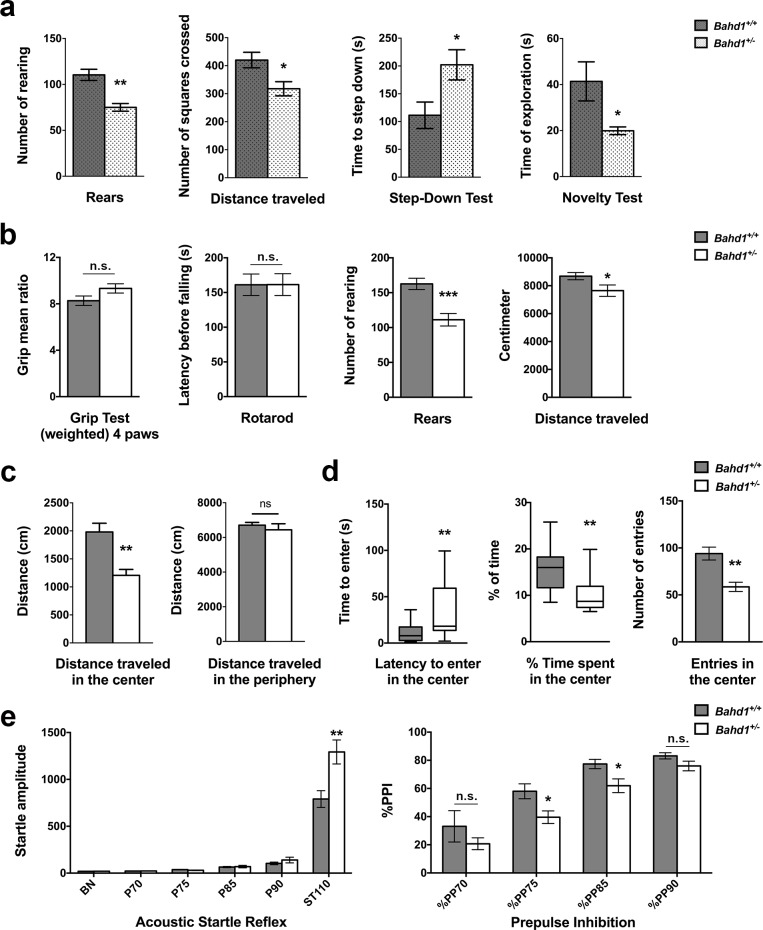
Bahd1+/- mice show behavioral abnormalities.(a) Analysis of Bahd1-Het1 mice in comparison with their WT littermates. Number of rearings and distance travelled in the open field test; step-down test; novelty test. (b-d) Analysis of Bahd1-Het2 mice in comparison with their WT littermates. (b) Grip test; rotarod test; number of rearings and distance travelled in the open field test. (c) Distance travelled in the center versus periphery in the open field test. (d) Behavior of mice in relation to the center of the arena in the open field test. (e) Acoustic startle reflex (ASR) and prepulse inhibition (PPI) analysis (BN, background noise; Px, stimuli of xdB such as P70 = 70 dB; ST110, acoustic startle pulse of 110 dB; %PPx, prepulse of xdB followed by a pulse of 110 dB). Data are the mean ± SEM or median ± interquartile range, depending on the data normality, as assessed by the Shapiro-Walk normality test. Asterisks indicate significant differences (* p<0.05, ** p<0.01, *** p<0.001).